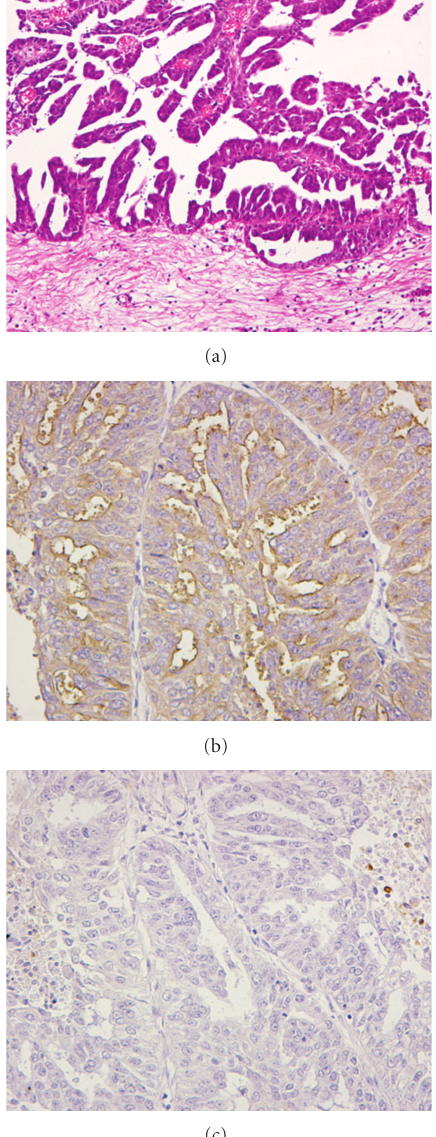
Figure 2: Lymphangioleiomyomatosis (LAM) of lung. In a gross section, multiple cysts are shown in the left lower lung (a). In the HE staining, a dramatic loss of the alveolar septum is associated with an increasing number of cysts. In the cysts, LAM cells are observed to increase in number along the peribronchiole or perilymphatic duct (b). The cytoplasm of the LAM cells is positive for HMB45